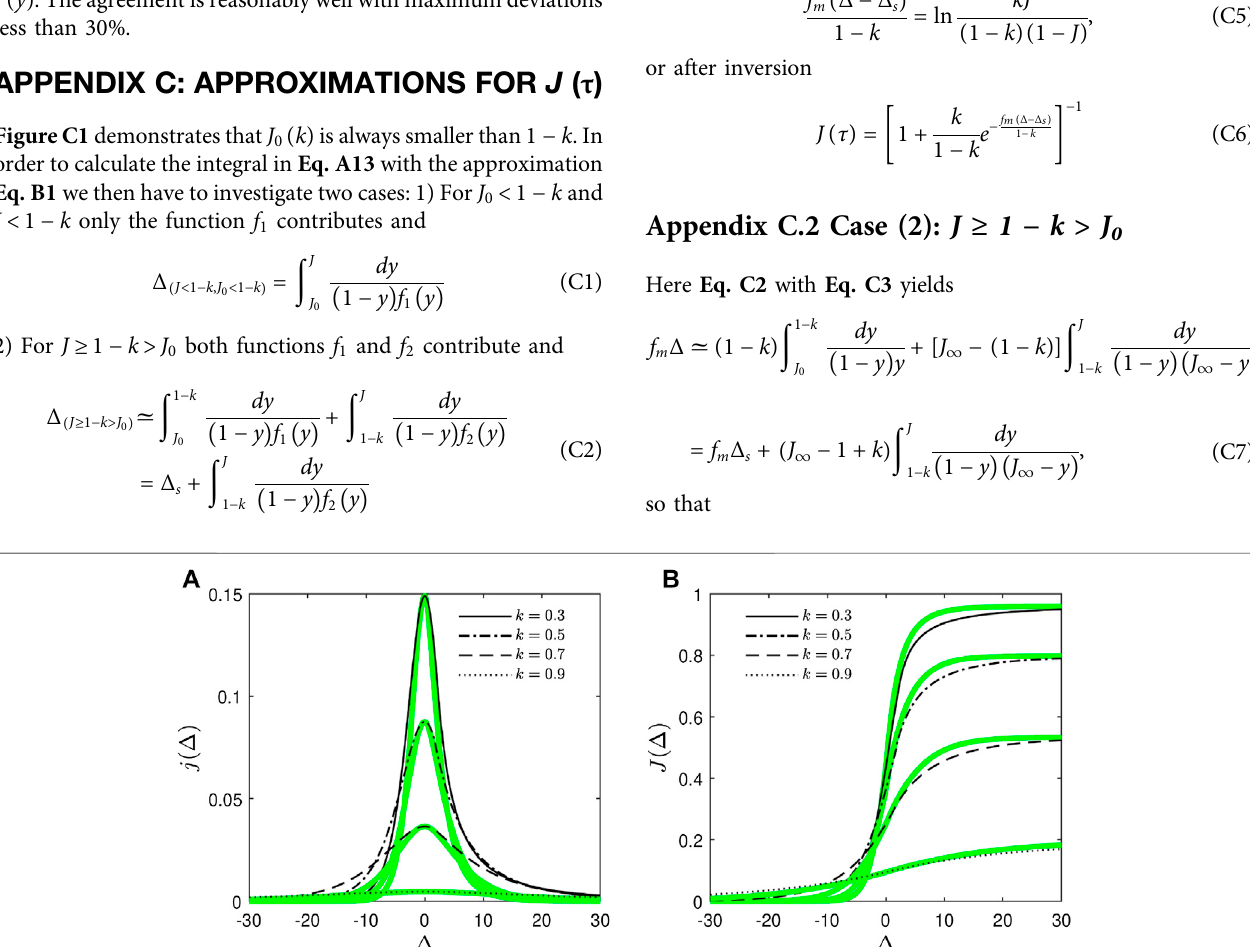
FIGURE C2 | Comparison for (A) j ( Δ ) and (B) J ( Δ ) between exact solution of the SIR model (green) and the approximant used here (black) for various k . Our approximant [19] in terms of Lambert ’ s function is shown as well, but coincides with the exact solution (green) in this representation.